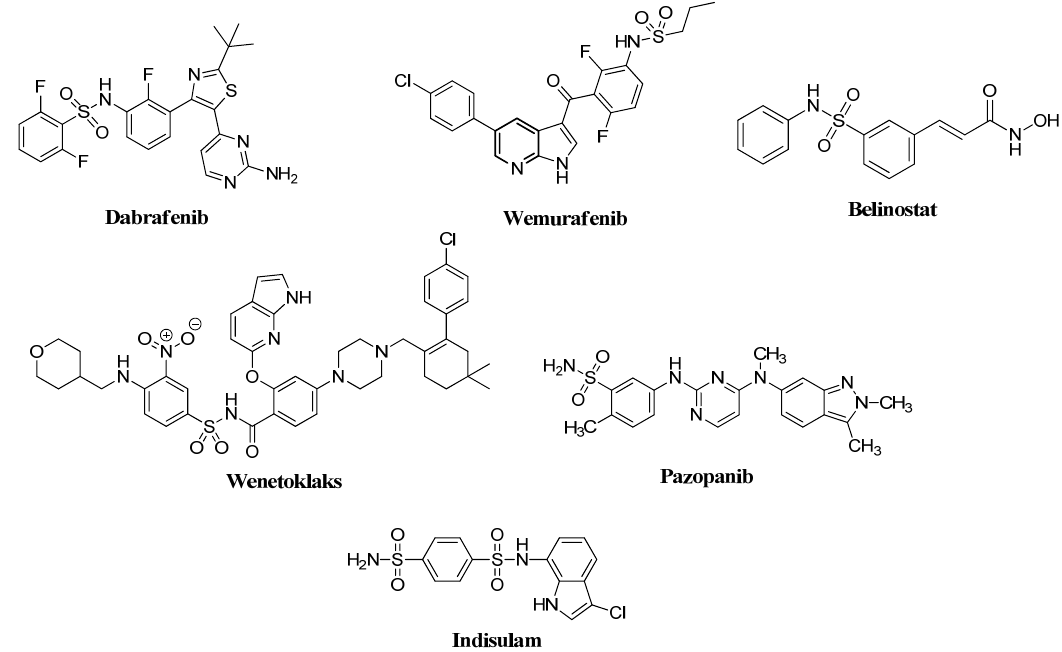
Figure 1. Sulfonamides with proven anticancer activity.